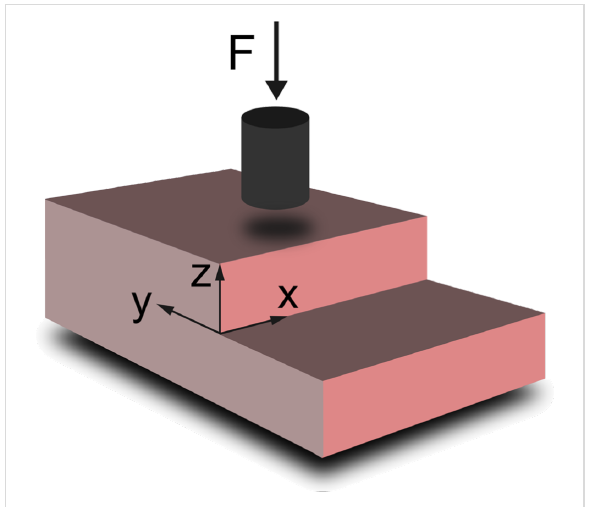
Figure 5: Schematic FEM configuration of the indentation on top of the step by using a flatpunch indenter.